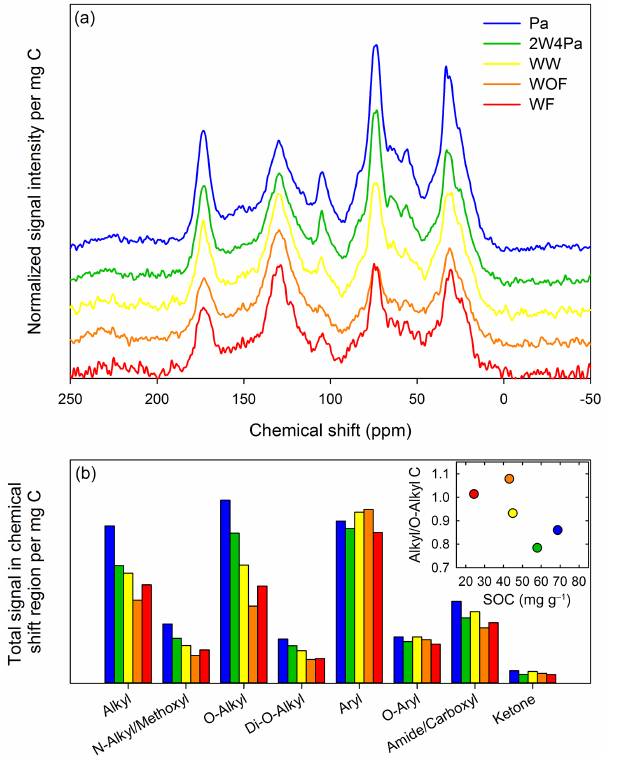
Figure 2. Solid-state 13 C NMR spectra (a) and total signal intensity integrated into eight major chemical shift regions (b) for the 1983 soil samples from the five treatments. Signal intensity has been nor- malized for number of scans, nc_proc, C observability and C con- tent in NMR rotor ( y axis units are irrelevant). Inset in (b) shows the alkyl C to O-alkyl C ratio plotted as a function of SOC content ( R 2 = 0 . 51, P =